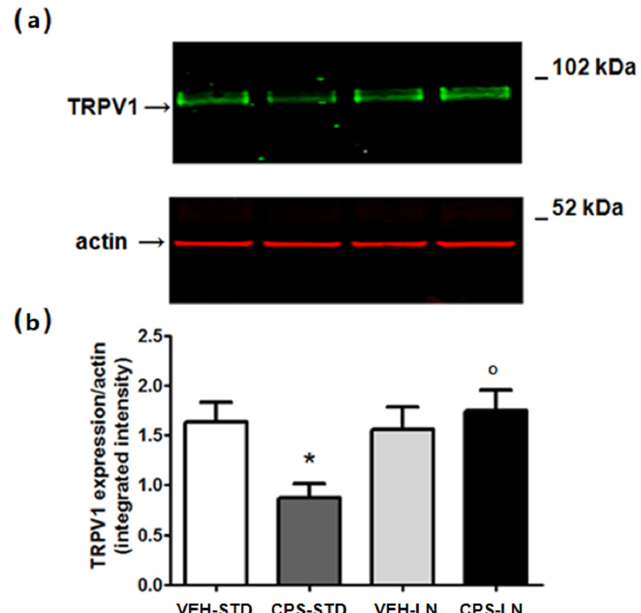
Figure 5. Expression of TRPV1 receptor in the skin of CD1 mice after seven days from the i.pl. injection of CPS included in standard vehicle or LN. I.pl. injection of CPS induces a significative downregulation of TRPV1 receptors that is blocked by LN inclusion. A representative immunoblot of TRPV1 in the skin of naïve mice and mice injected with capsaicin (0.125% / 10 µ L) in the absence or presence of LN is shown in ( a ). Densitometric analysis is shown in ( b ), where values are means + S.E.M. of four determinations. * p < 0.05 vs. vehicle mice; o p < 0.05 vs. mice injected with capsaicin (one-way ANOVA followed by Fisher’s post hoc